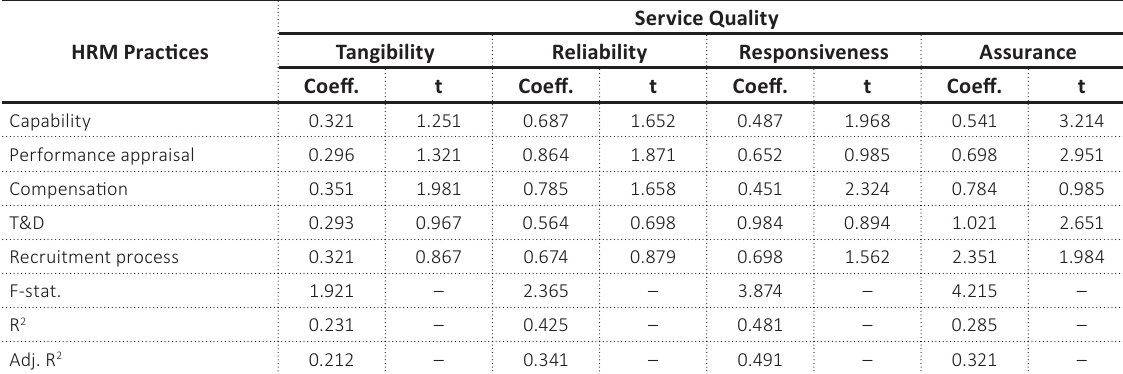
Table 7. Test of the third hypothesis